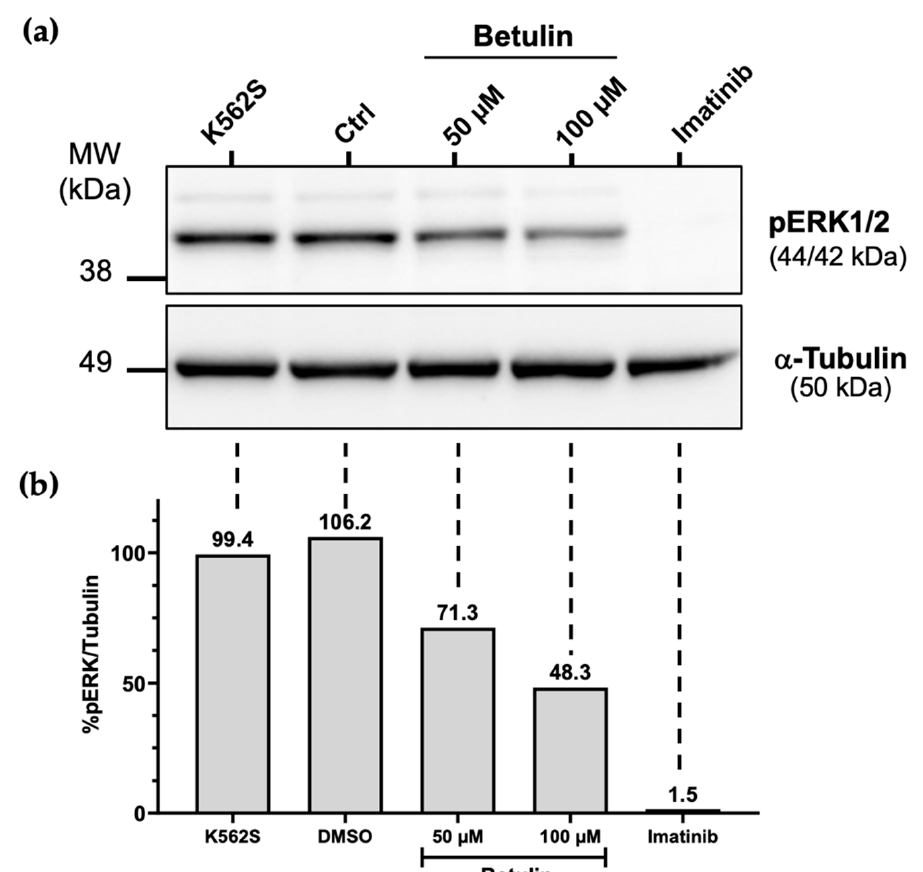
Figure 6. Effects of betulin on extracellular signal-regulated kinase (ERK) signaling. ( a ) K562S CML cells that were untreated (K562S) or treated with 1% DMSO, 50 or 100 µM betulin, or 20 µM of imatinib mesylate for 6 h were subjected to an immunoblot analysis as described in the Methods section. Briefly, extracts of treated K562S cells were analyzed by SDS-PAGE, followed by Western blotting with antibodies directed against phospho-ERK1/2 (Thr202/Tyr204) and α -Tubulin (as a loading control). ( b ) The open source image processing program “ImageJ” was used to quantify the intensity of each band.